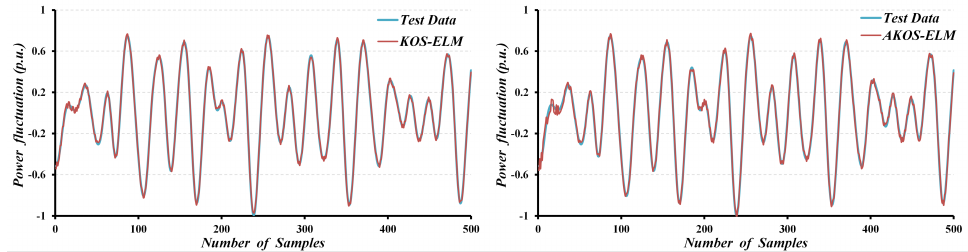
Figure 5. Prediction performance comparison of KOS-ELM, AKOS-ELM, OS-ELM, En-ELM, LSTM using Level-5 data set (part